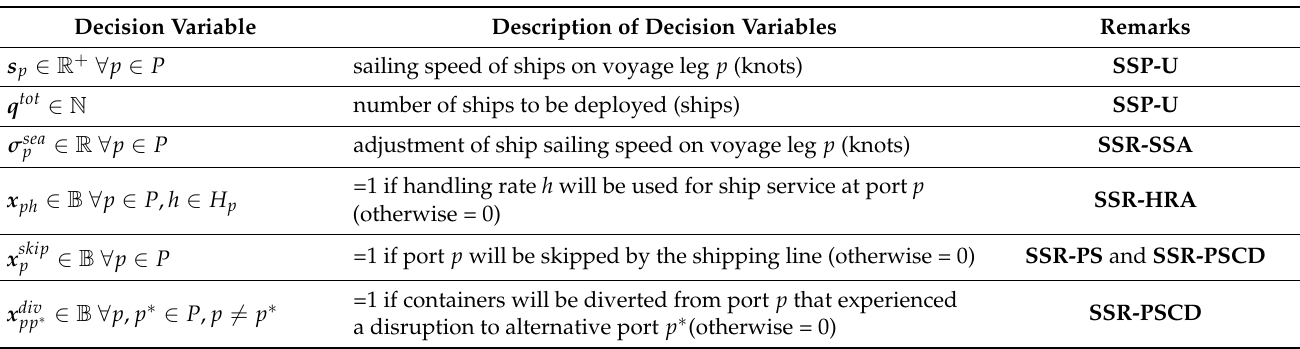
Table A2. Definition of decision variables.